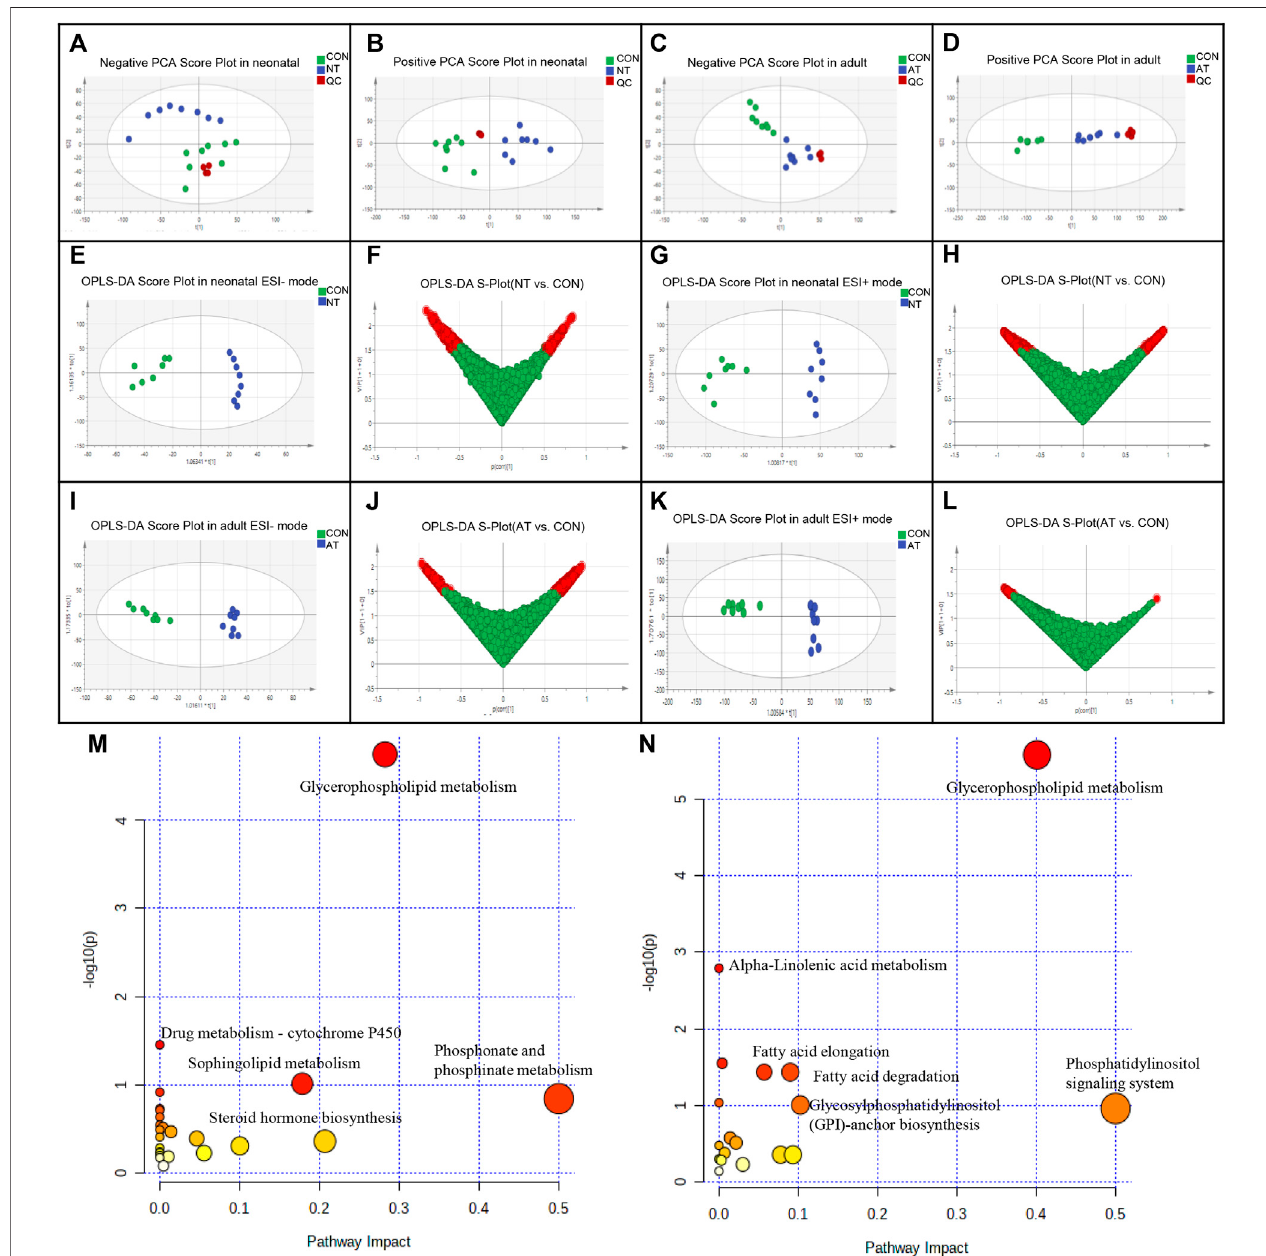
FIGURE 3 | Metabolomic analysis of AAI-treated neonatal (NT) and adult mice (AT). Principal component analysis (PCA) scores for AAI-treated mice with the fi rst two principal components: (A) negative ion mode of NT; (B) positive ion mode of NT; (C) negative ion mode of AT; (D) positive ion mode of AT. Discrimination of AAI- treatedmice andcontrolmice(CON)accordingtoorthogonalprojectiontolatentstructuresdiscriminateanalysis(OPLS-DA)modelintheESI − /+ mode.Thepointsinred indicatetheidenti fi edbiomarkers. (E) OPLS-DAscoreplotsofNTandCONintheESI-mode; (F) ScoreplotoftheOPLS-DAmodelfortheCONandNT; (G) OPLS- DA score plotsofNTand CON inthe ESI +mode; (H) Scoreplot oftheOPLS-DAmodel for theCON and NT; (I) OPLS-DAscore plots ofATand CON in theESI- mode; (J) ScoreplotoftheOPLS-DAmodelfortheCONandAT; (K) OPLS-DAscoreplotsofATandCONintheESI+mode; (L) ScoreplotoftheOPLS-DAmodelfortheCON and AT. Metabolome view of the pathway analysis generated using MetaboAnalyst 5.0 based on differential metabolites between AAI-treated mice and CON. The size and colorofeach circlewerebasedonthepathway impactvalueand p value,respectively. (M) Summaryofingenuitypathway analysisintheNTgroup. (N) Summaryof ingenuity pathway analysis in the AT group.